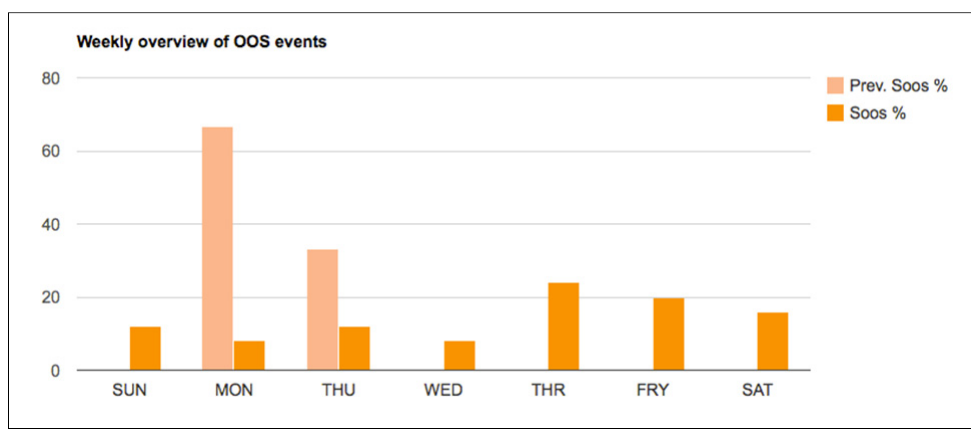
Figure 15. Weekly comparison in rate of SOOS and estimate of